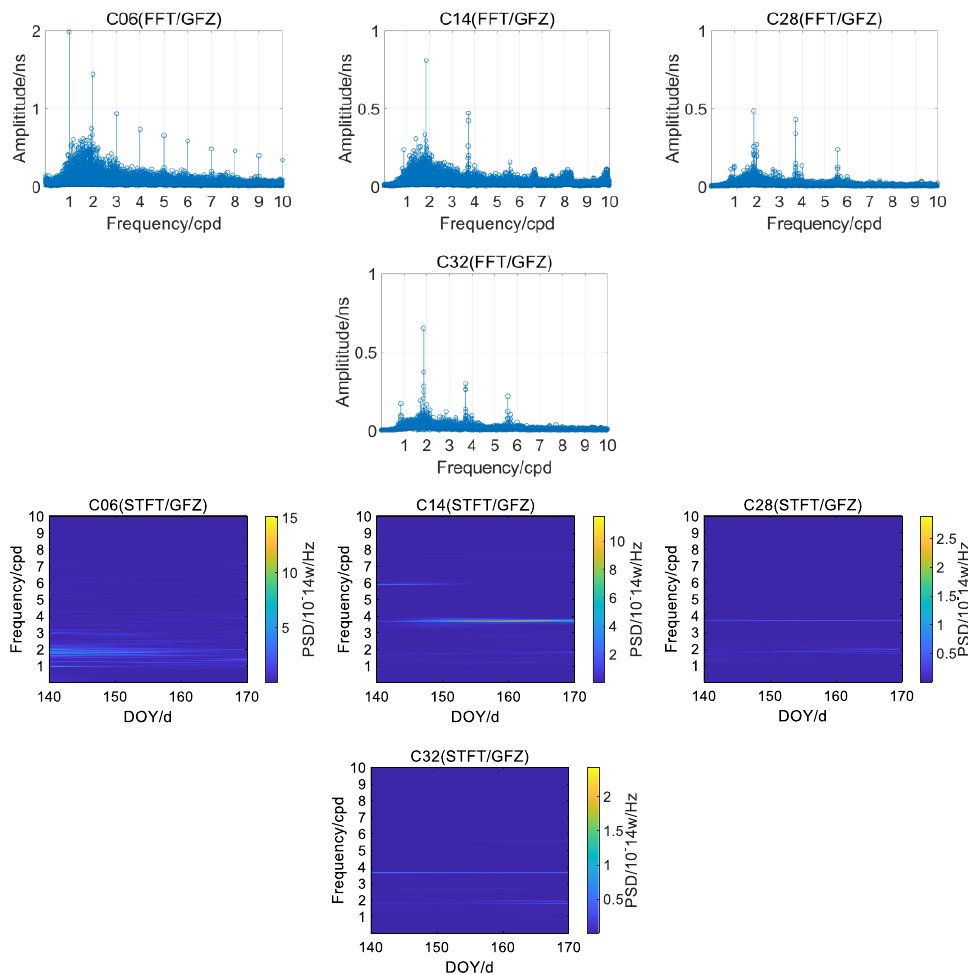
Figure 12. Amplitude spectrums and spectrograms of GFZ clock offsets.